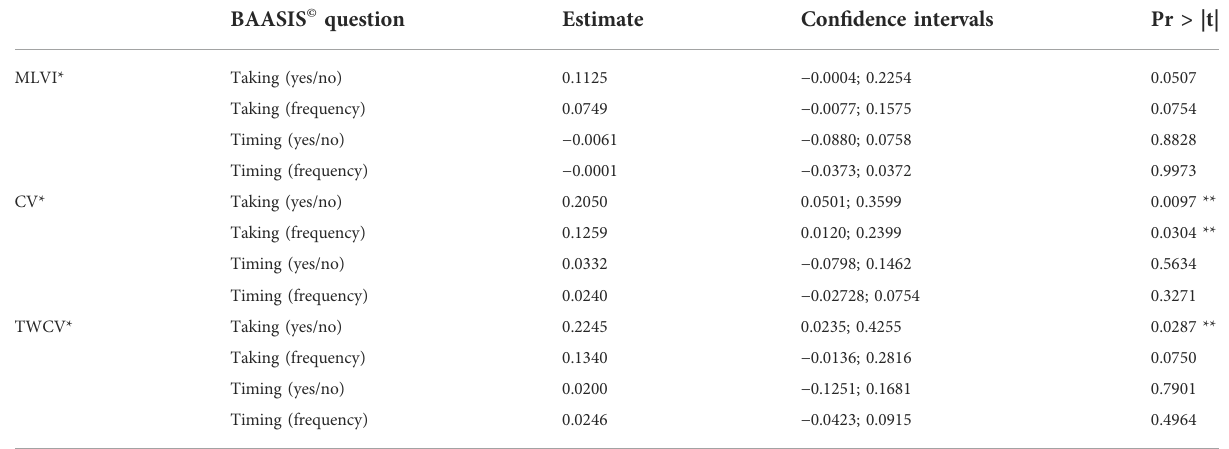
TABLE 3 Modeling of tacrolimus intra-patient variability by the BAASIS ( N =